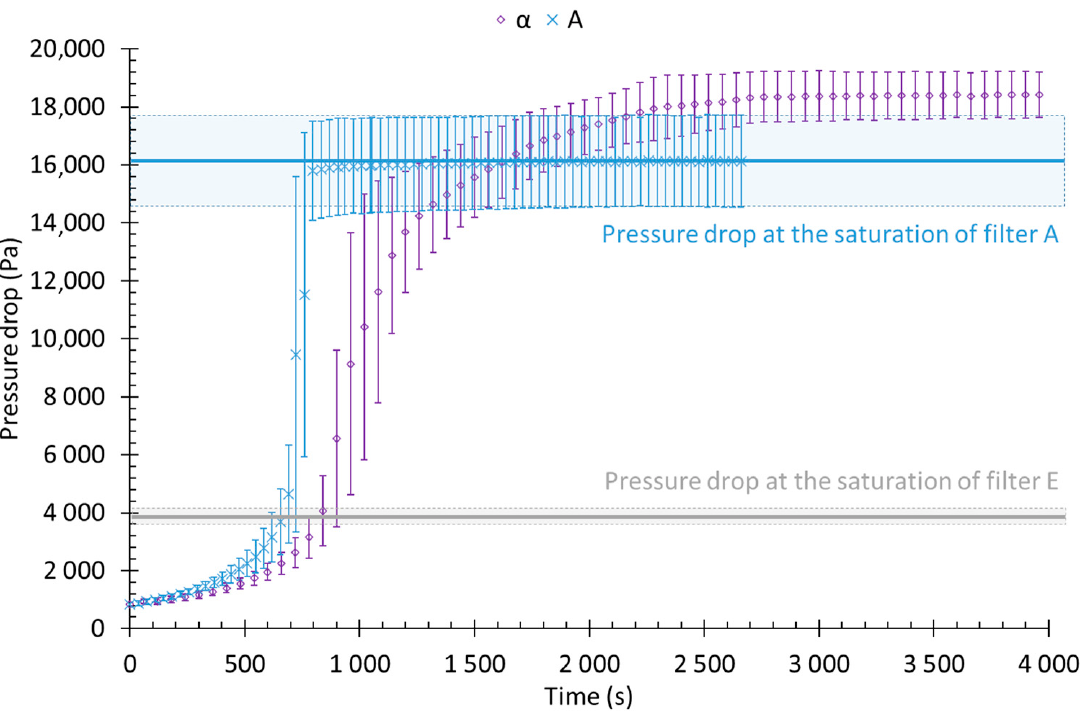
Figure 9. Pressure drop evolution as a function a surface mass, for a multilayer filter and the associated layers at a filtration velocity of 6 cm/s.